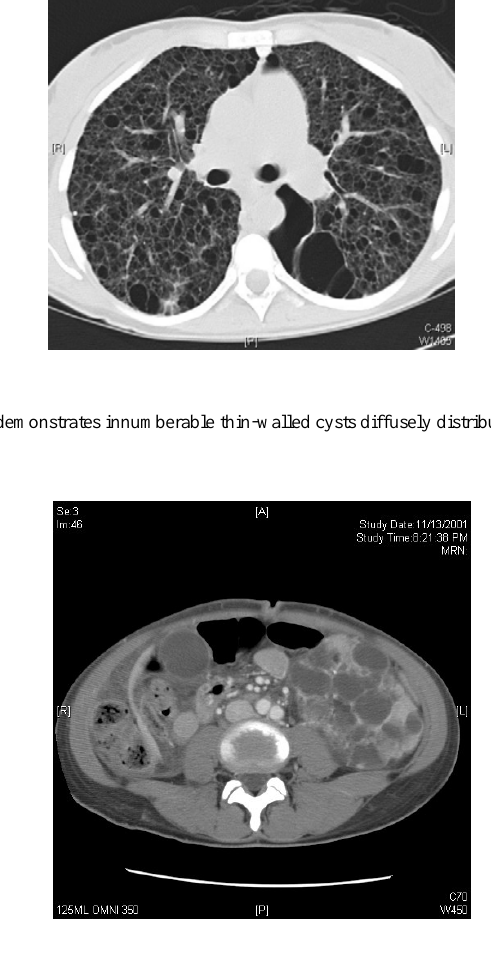
FIGURE 2. CT kidney shows a massive left kidney measuring 17.7 cm in cephalocaudal extent with innumerable cysts, interposed by